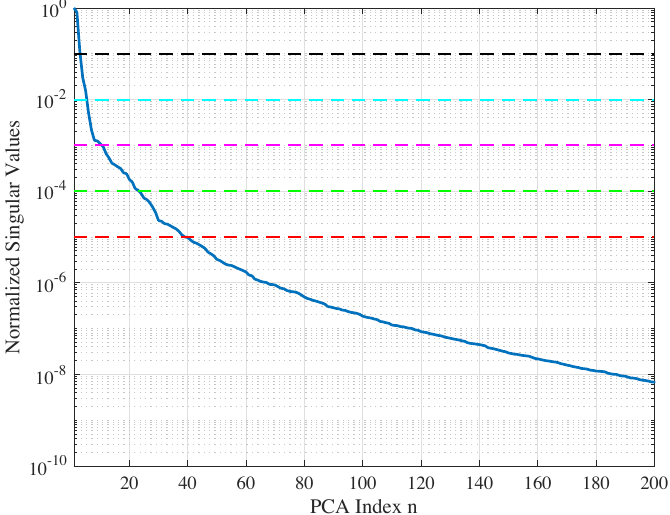
Figure 6. Normalized singular values of a training dataset for Case 1 with L = 450 responses (solid blue curve). The horizontal dashed lines indicate different thresholds for the PCA